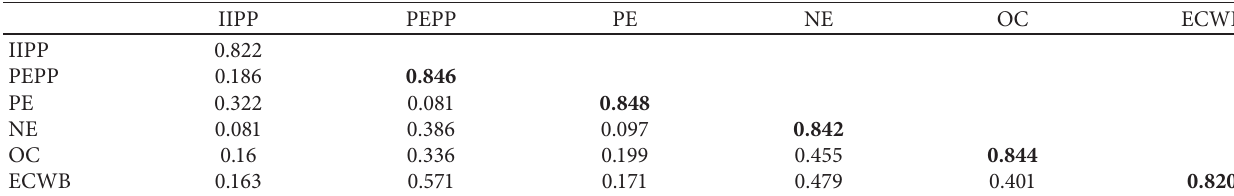
Table 4: Discriminant validity analysis.